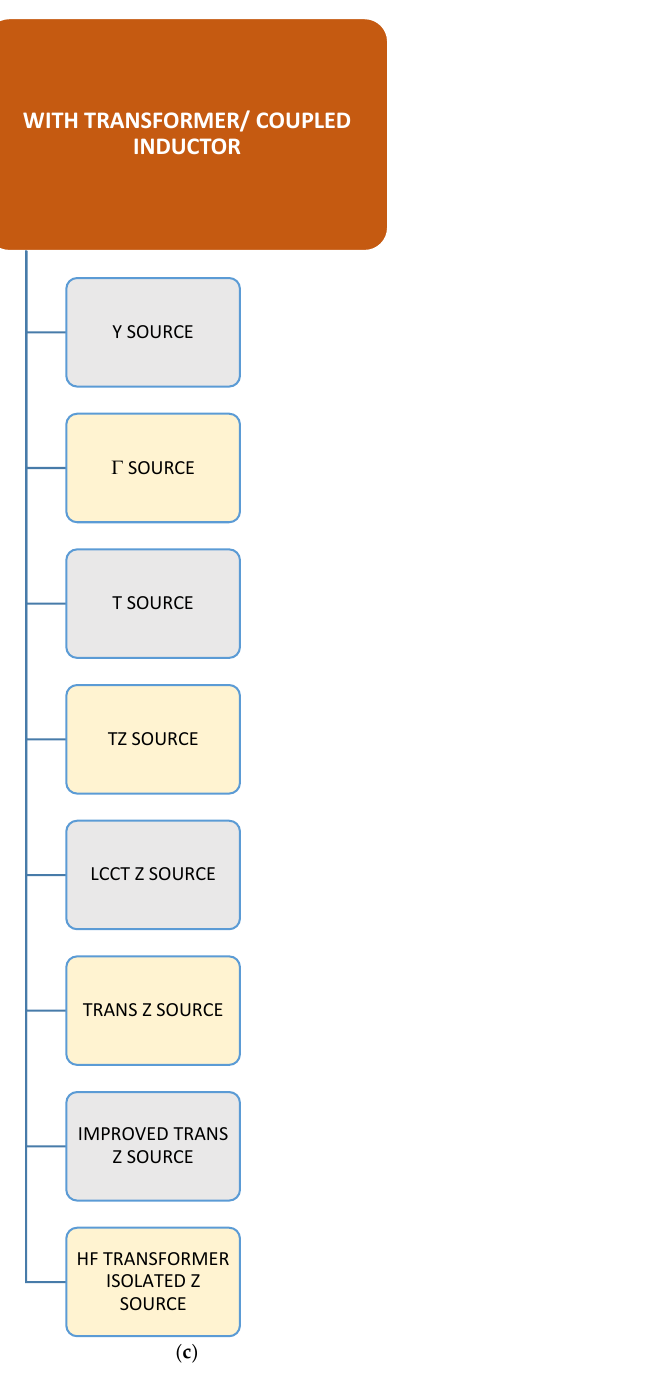
Figure 12. ( a ) Broad classification of Z source network topologies. ( b ) Classificztion of Z source transformerless topologies. ( c ) Classification of Z source topologies with transformer / coupled inductor. Summaries of stateof the art PV-grid inverter topologies of Z source networks without transformer and with transformer / coupled inductor arepresented in Tables 3 and 4 respectively. The features of each structure with components used, including passive elements and semiconductor devices peer reviewed from di ff erent literature works are listed. Detailed topological figures can be obtained from the respective reference papers cited for each structure listed in the